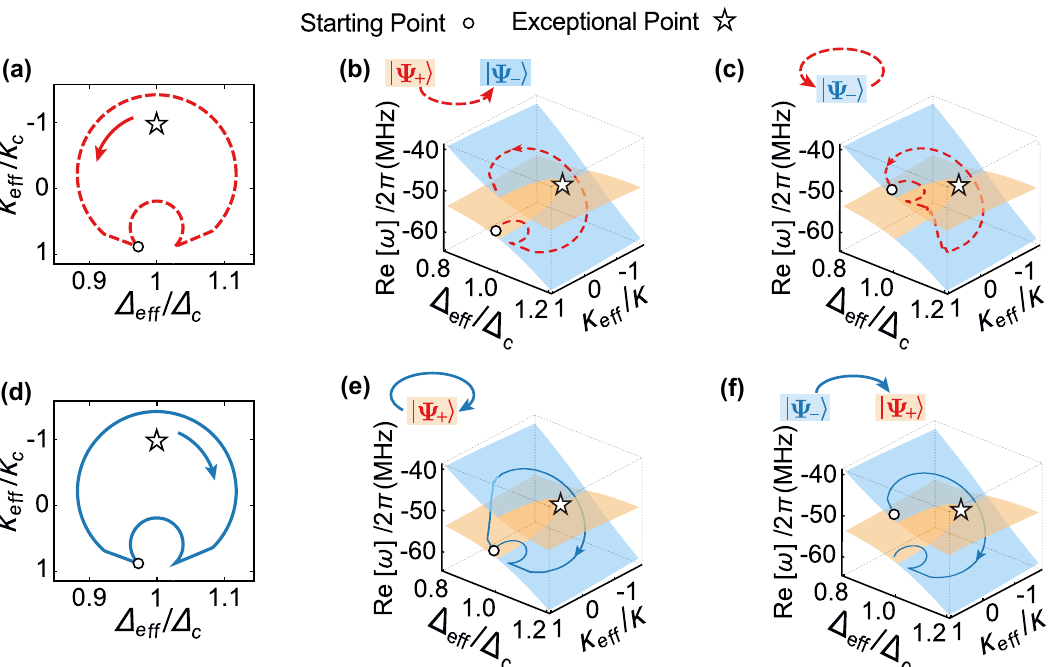
Figure 2: Energy dynamics Re [ 𝜔 ] and their trajectories with chirality follow the loops of topological operations with EP. (a and d) Loops of the topological operation, where the topological trajectories start from the initial eigenmodes plotted in the following panels. (b and e) Initial eigenmode | 𝜓 + ( t = 0) ⟩ and (c and f) initial eigenmode | 𝜓 − ( t = 0) ⟩ in the parameter spaces of the eigenenergy Re [ 𝜔 ], effective and decay rate 𝜅 . Arcs with arrows represent the topological operation directions in CCW (dashed red) and CW (solid blue). detuning Δ eff eff Here, eigenenergies for eigenmodes | 𝜓 + ⟩ and | 𝜓 − ⟩ are plotted in orange and blue. Parameters for simulations are T = 0 . 01 ms, 𝜔 ∕ 2 𝜋 = 51 . 8 MHz, 𝛾 ∕ 2 𝜋 = 41 kHz, m = 20 ng, Δ = − 𝜔 = 𝜅 = 𝜅 , 𝜆 = 390 nm, 𝜒 ∕ 2 𝜋 = 12 × 10 18 ℏ , g ∕ 2 𝜋 = 5 MHz, 𝜅 ∕ 2 𝜋 = 5 MHz, 𝜅 c c a m m m [8, 34, 63,